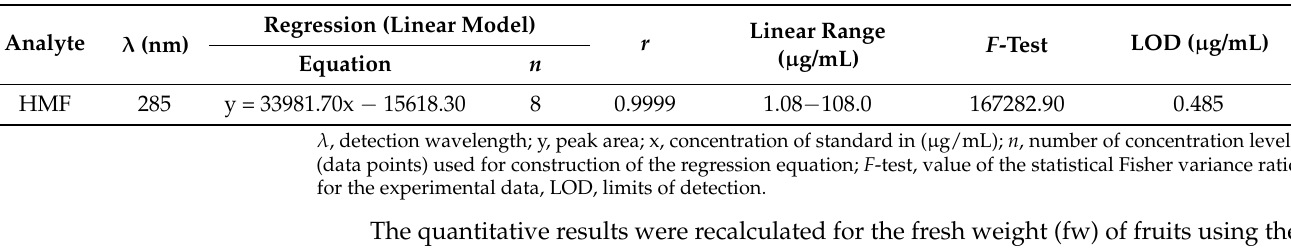
Table 3. Validation parameters for HPLC-PDA quantitative